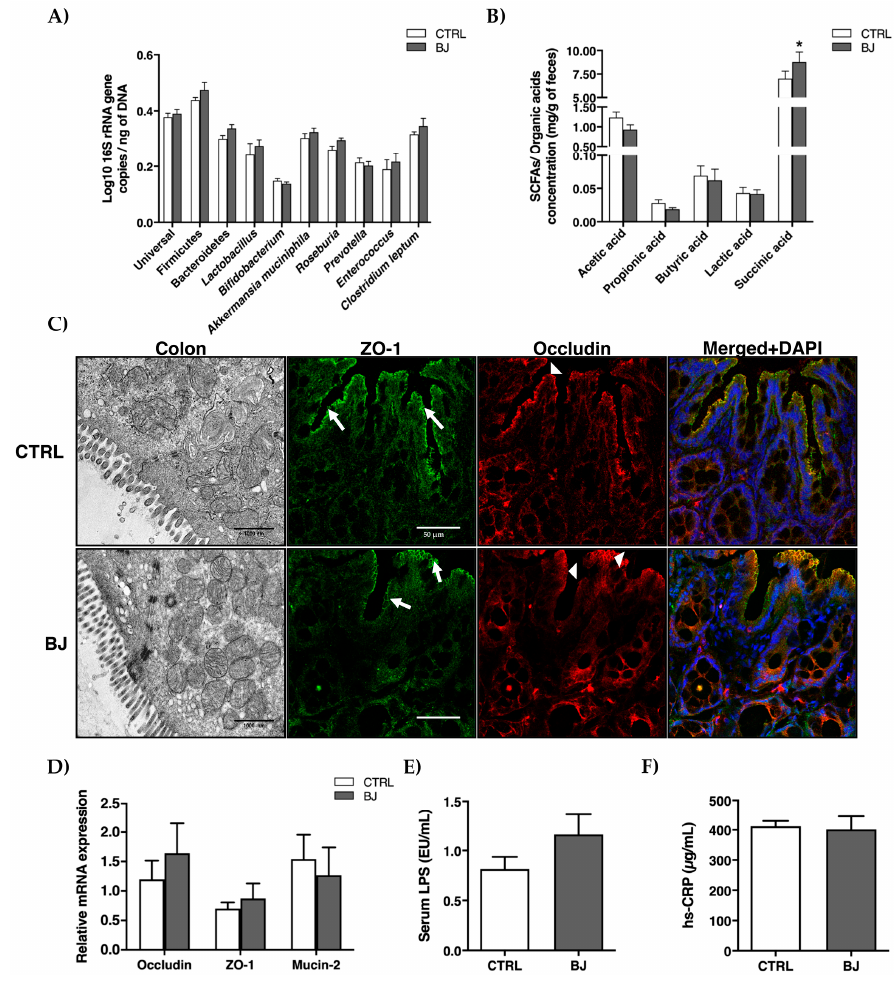
Figure 1. Gut microbiota composition ( A ), SCFAs, and organic acids ( B ) in feces; ultrastructural distribution of tight junctions and representative confocal images of colon section stained for ZO-1 (arrow) and occludin (arrowhead) ( C ) and mRNA expression ( D ) of key players of tight junctions; serum LPS ( E ) and hs-CRP ( F ) concentrations. Data are presented as mean ± SEM ( n = 6–8 / group); * p < 0.05 vs. CTRL group.